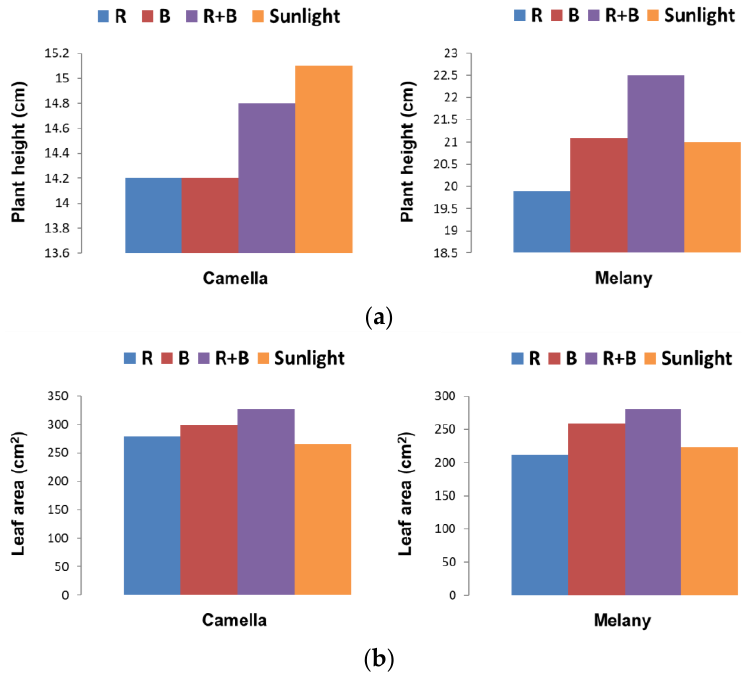
Figure 1. Comparison of plant growth using sunlight and LED lights. Plant height (a); Leaf area (b) [16]. Table 2. Effects of light sources with the different photosynthetic photon flux density (PPFD) on the plant.